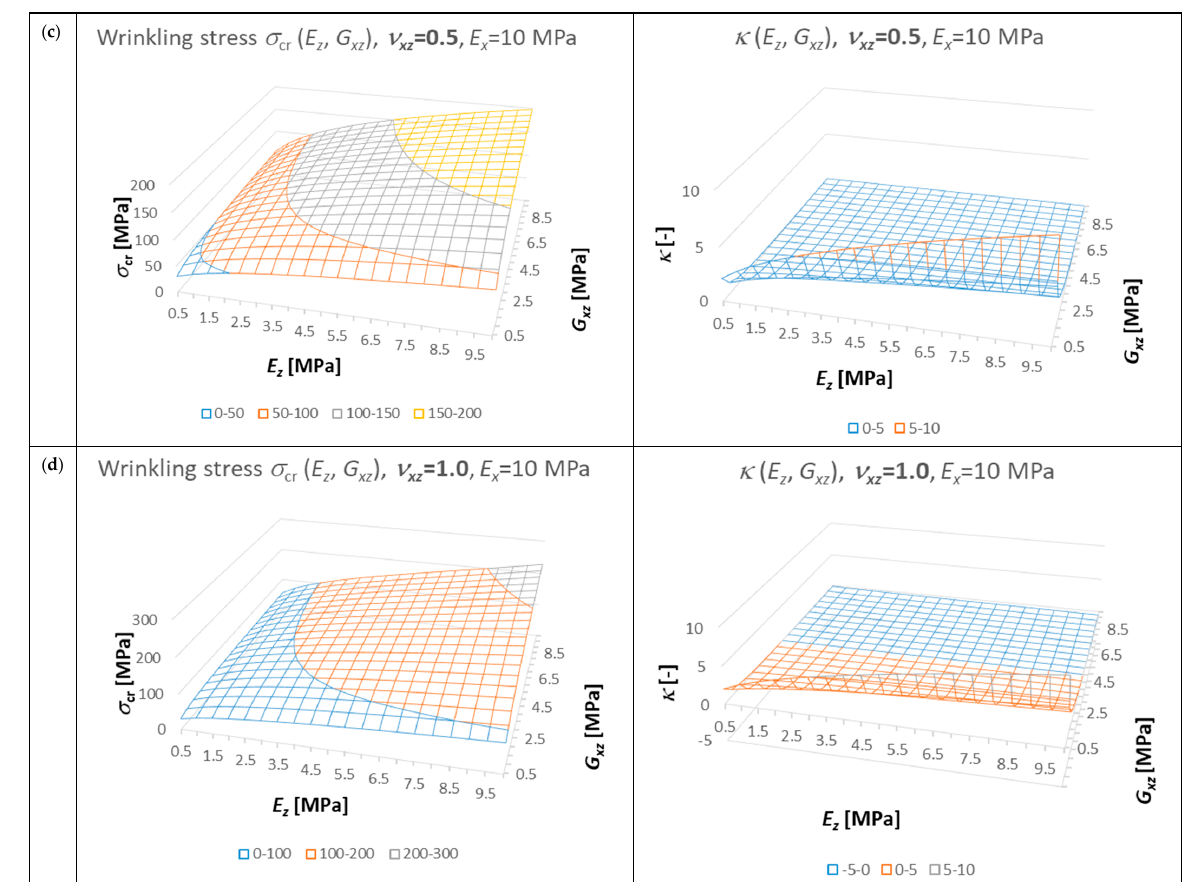
Figure 8. Influence of core material parameters on the value of wrinkling stress and the parameter κ : ( a ) ν xz = − 1.0, ( b ) ν xz = 0, ( c ) ν xz = 0.5, ( d ) ν xz = 1.0.